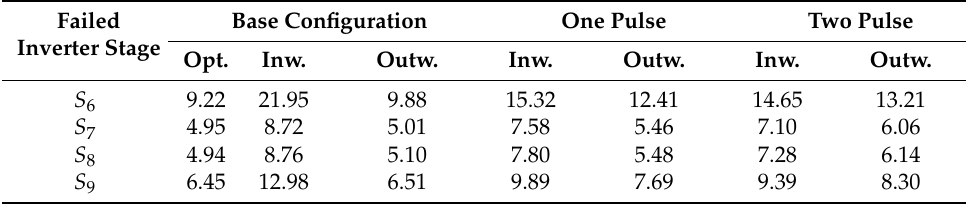
Table 4. Comparison of THD (%) for different methods studied.